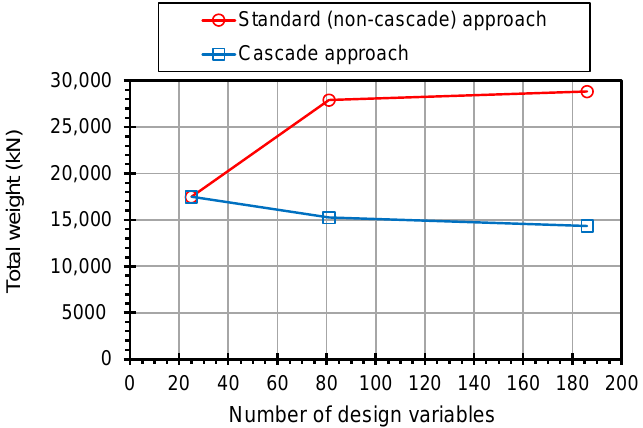
Figure 11. Test Problem 2 (36-story steel space frame): trade-off relation between the number of design variables and the finally attained objective function value.